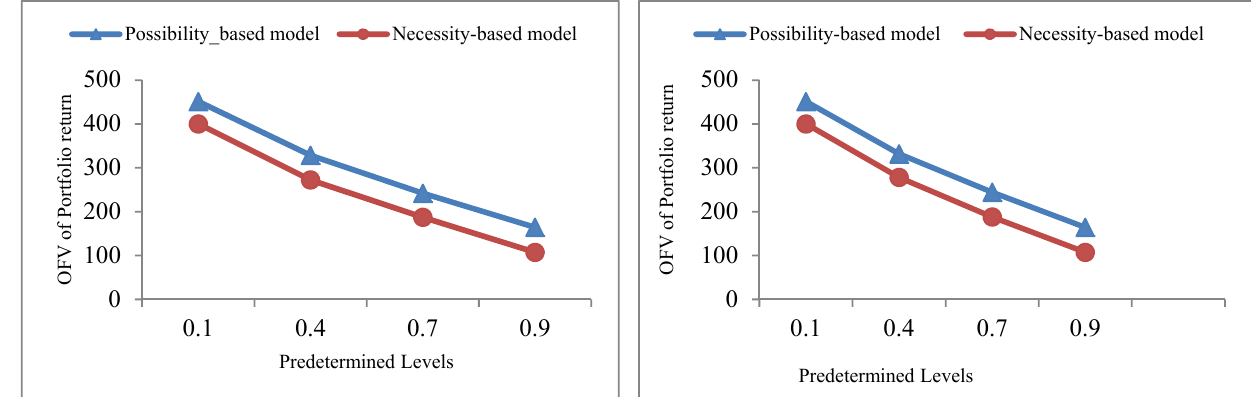
Fig. 1. Comparison of Possibility and Necessity-based model in single objective